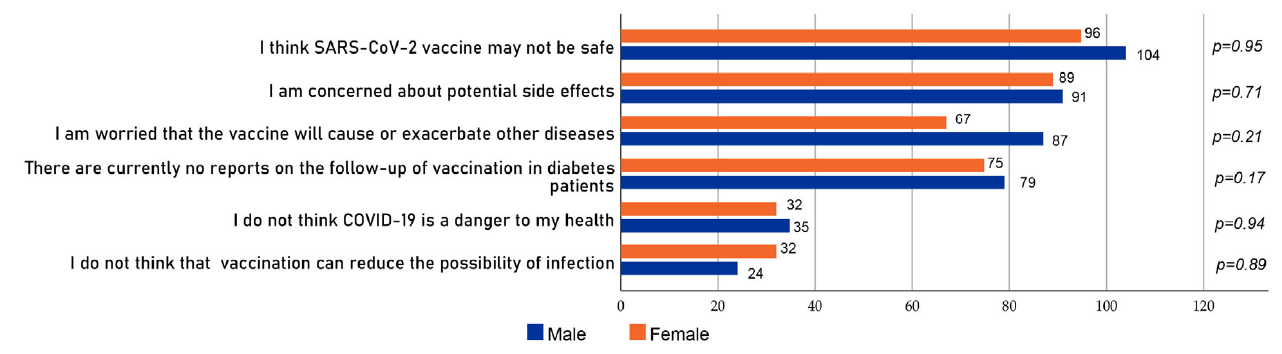
Figure 2. Reasons for SARS-CoV-2 vaccine hesitancy among study participants ( n =